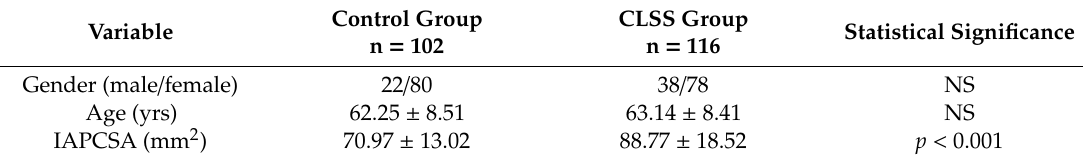
Table 1. Comparison of subjects between control and CLSS